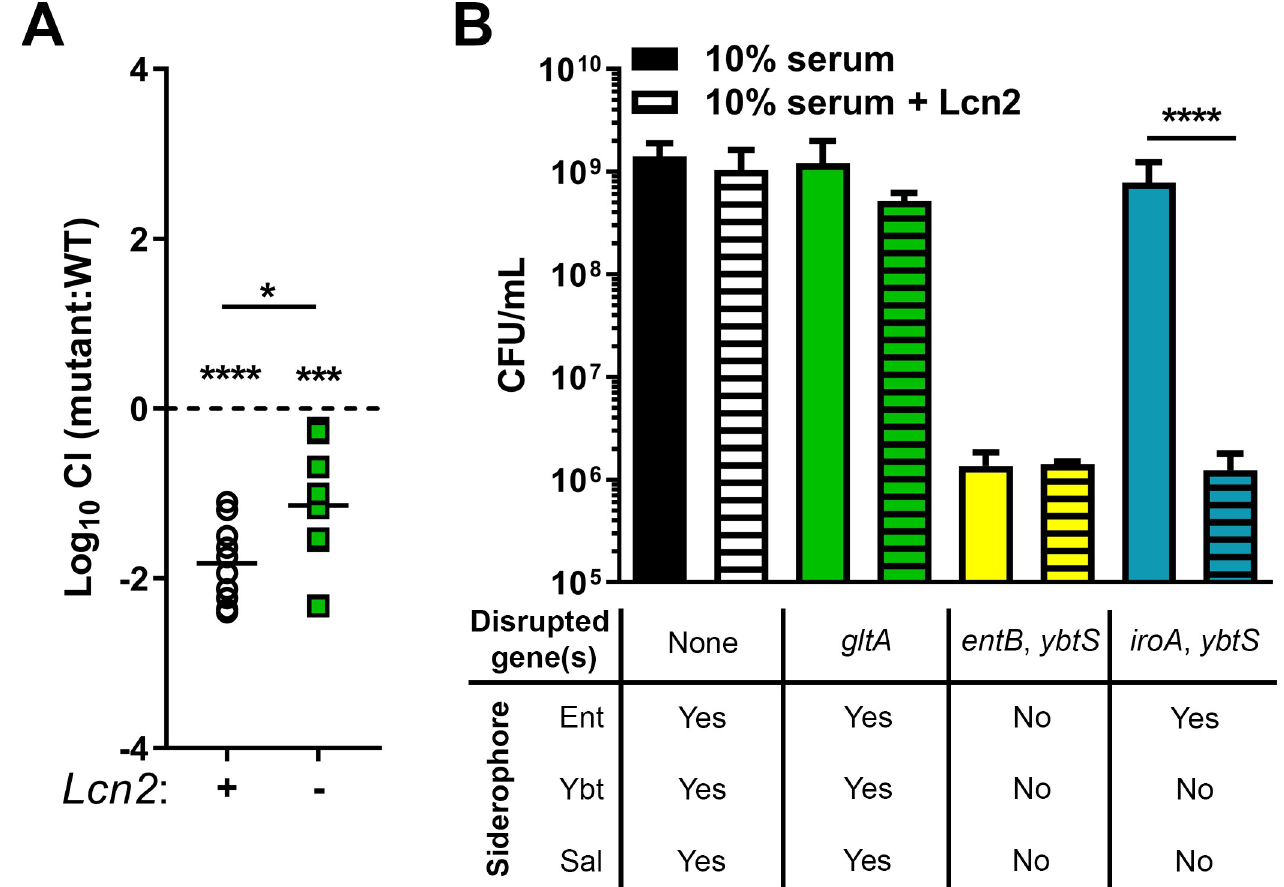
Fig 1. The Kp citrate synthase, gltA , interacts indirectly with Lcn2 during lung infection. (A) A gltA (VK055_1802) mutant was constructed and used to validate InSeq findings. C57BL/6J mice or isogenic Lcn2 -/- mice were retropharyngeally inoculated with approximately 1 × 10 6 CFU of a 1:1 mix of WT KPPR1 and KPPR1 Δ gltA . Lung bacterial burden was measured after 24 hours, and log 10 competitive index of the mutant strain compared to the WT strain was calculated for each mouse strain (n = 10, mean displayed, � P < 0.05, ��� P < 0.0005, ���� P < 0.00005, one-sample t test or Student’s t test). (B) WT KPPR1 and various isogenic mutants were grown in RPMI + 10% (v/v) heat-inactivated resting human serum ± purified recombinant human Lcn2 overnight, then total CFU was enumerated by dilution plating on selective media (n = 3–4, mean displayed ± SEM, ���� P < 0.00005, Student’s t test).